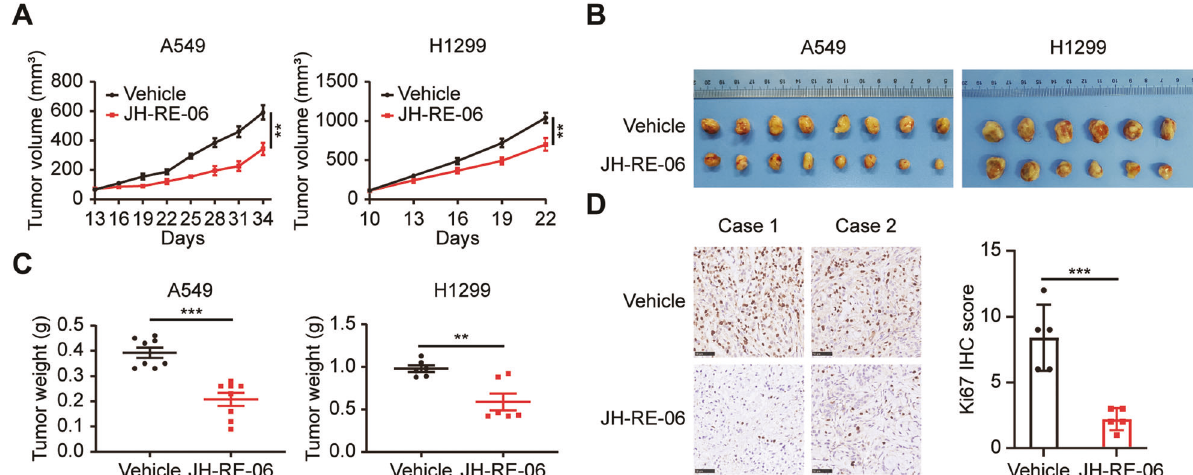
Fig. 3 The REV1 inhibitor JH-RE-06 suppresses lung tumorigenesis in vivo. A Xenograft tumor growth curves in the two groups. Tumor volumes were measured every three days. The data are shown as the mean tumor volumes ± SEMs. ** P < 0.01 ( n = 8 or 6 mice per group). B Pictures of xenografts formed from A549 and H1299 cells with the indicated treatment. C Weights of xenograft tumors. ** P < 0.01, *** P < 0.001 ( n = 8 or 6 mice per group). D Representative images of IHC staining for Ki67 in xenograft tumors in the two groups and statistical histograms of the IHC score. *** P < 0.001 ( n = 5). Scale bar: 50